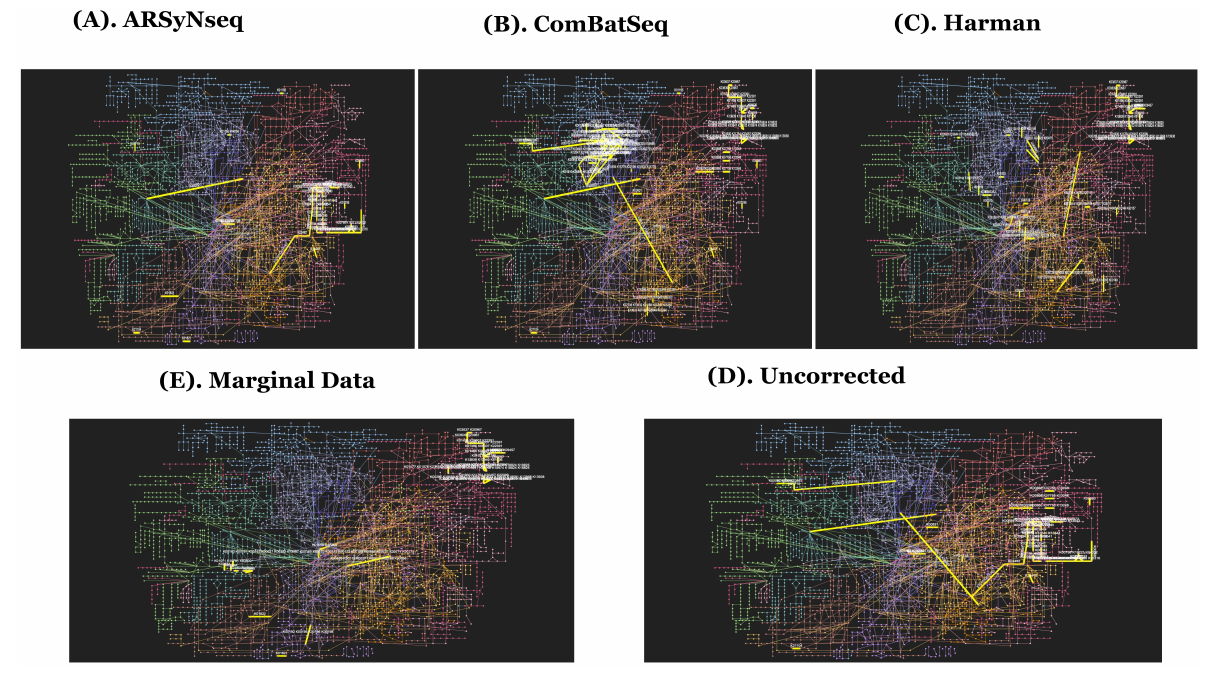
Figure 6. ( A – E ) show the network enrichment KEGG pathways generated from MicrobiomeAna- lyst [27,28] to represent overall functional profiling in association analyses (ARSyNseq, ComBatSeq, Harman, Uncorrected, and Marginal Data) in clockwise from top-left. Note that top 5 significant modules in yellow edges are presented in figures [27,28].